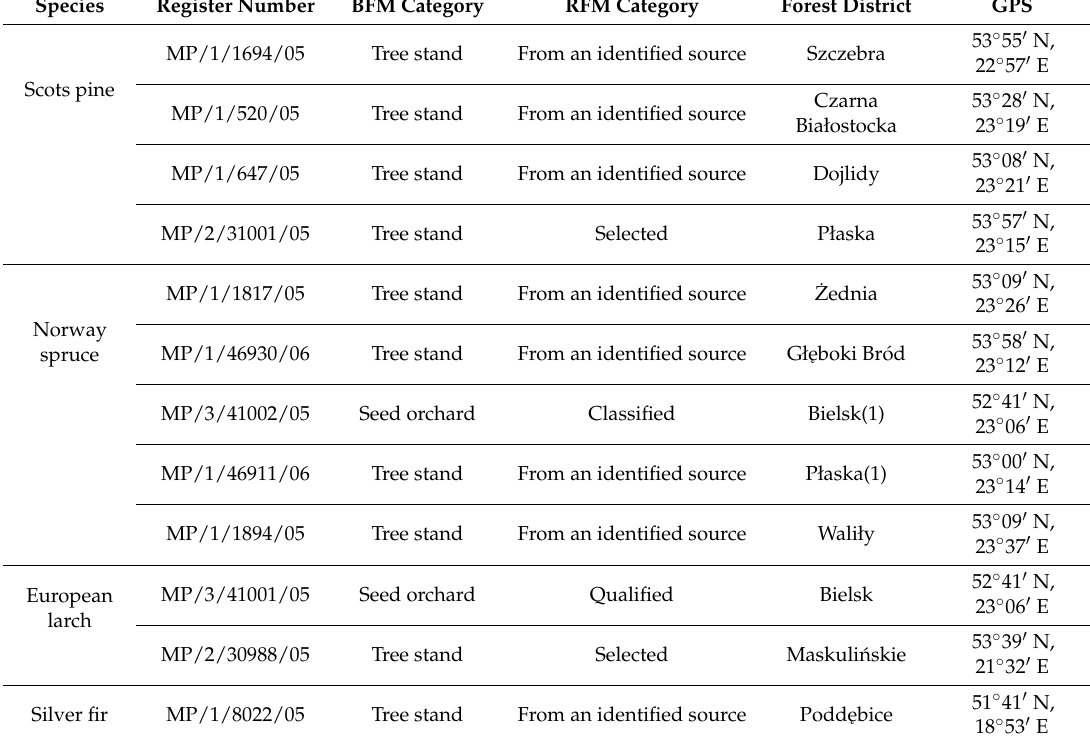
Table 1. Cone harvest sites—register number, basic forest material (BFM) category, reproductive forest material (RFM) category, and administrative forest